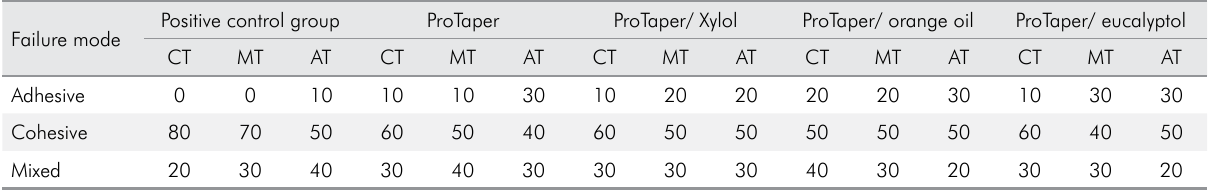
CT = coronal third; MT = middle third; AT = apical third.